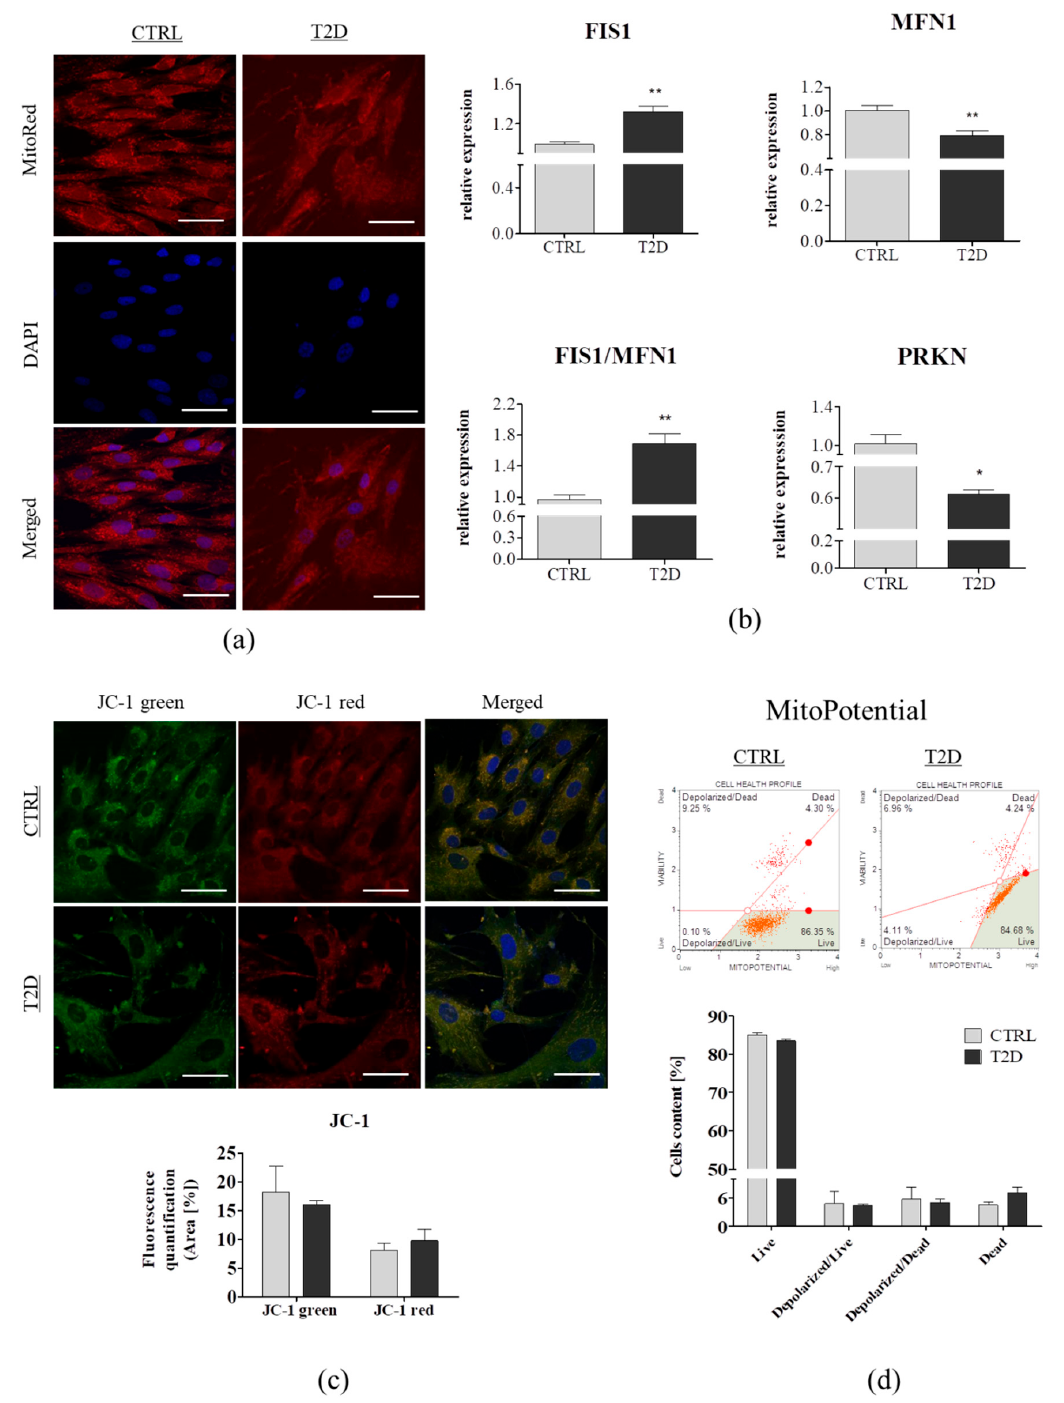
Figure 3. Mitochondrial dynamics and mitochondrial membrane potential in the ASC CTRL ( n = 6) and ASC T2D ( n = 6). ( a ) Representative images of mitochondria visualization in ASCs with MitoRed (red) and DAPI (blue) staining, using confocal microscopy. Scale bar: 50 µm. ( b ) Transcript levels of mitochondrial dynamics-related genes, assessed using qRT-PCR. ( c ) Mitochondrial membrane potential estimation by JC-1 staining, using confocal microscopy. ( d ) MitoPotential Analysis using the Muse Cell Analyzer. Fluorescence intensity of JC-1 staining was quantified using Image J. Results are expressed as mean ± SD. Statistical significance is indicated by asterisks (*): * p < 0.05, ** p < 0.01, and *** p < 0.001 were examined by an unpaired Student’s t -test. Scale bar: 50 µm.